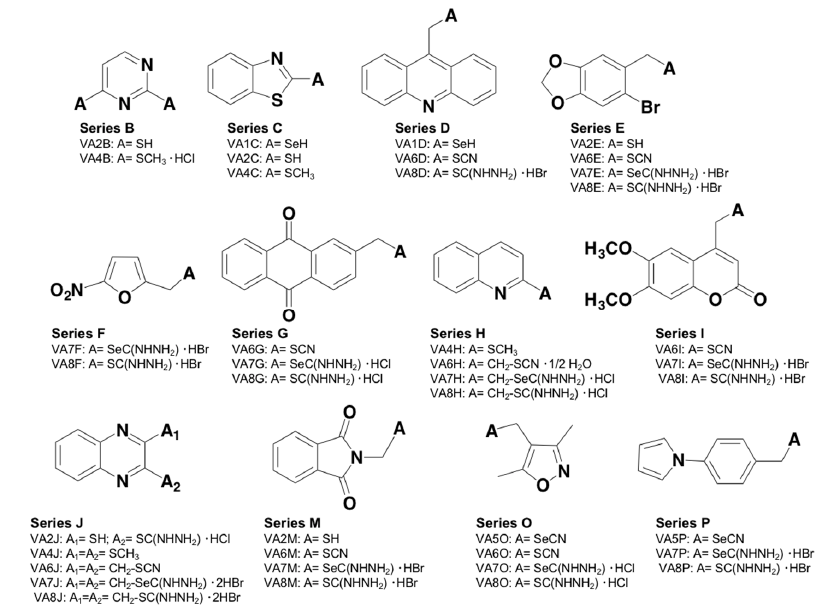
Figure 1 . Structures of S and Se heteroaryl compounds studied in this work. The compounds VA6G, VA6H, VA6I, VA2J, VA4J and VA6J are novel molecules. The structures of series 7 and 8 have been previously described [29] and the remaining ones have been extracted from a previous work from